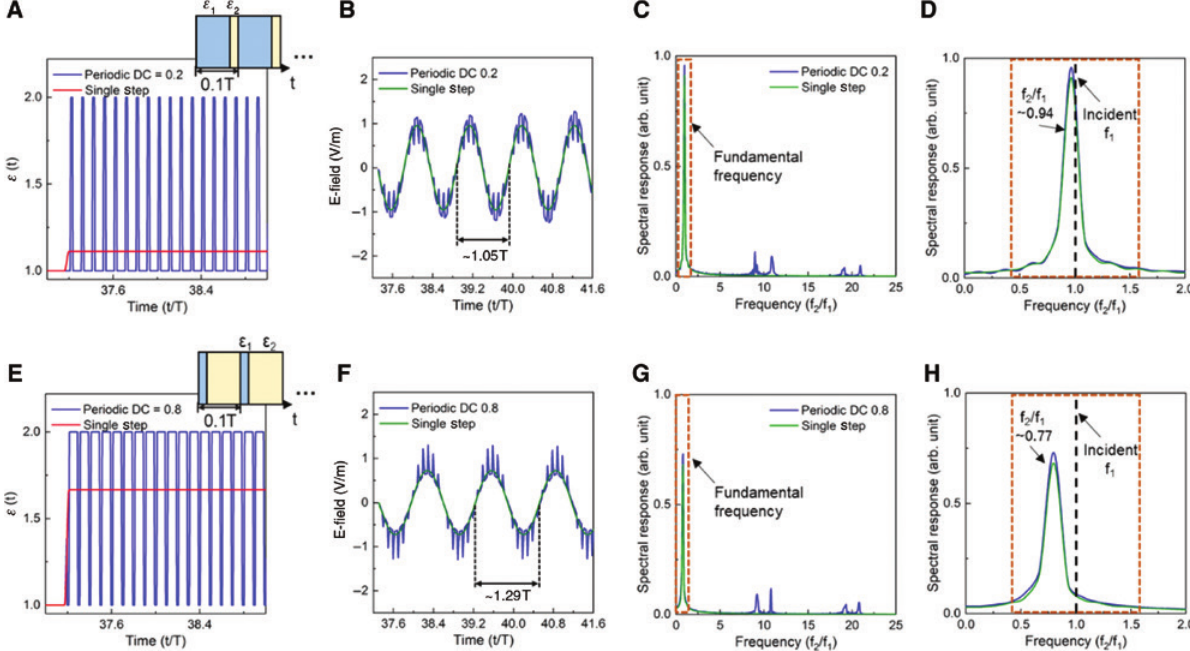
Figure 5: E-field distribution considering larger values of ε